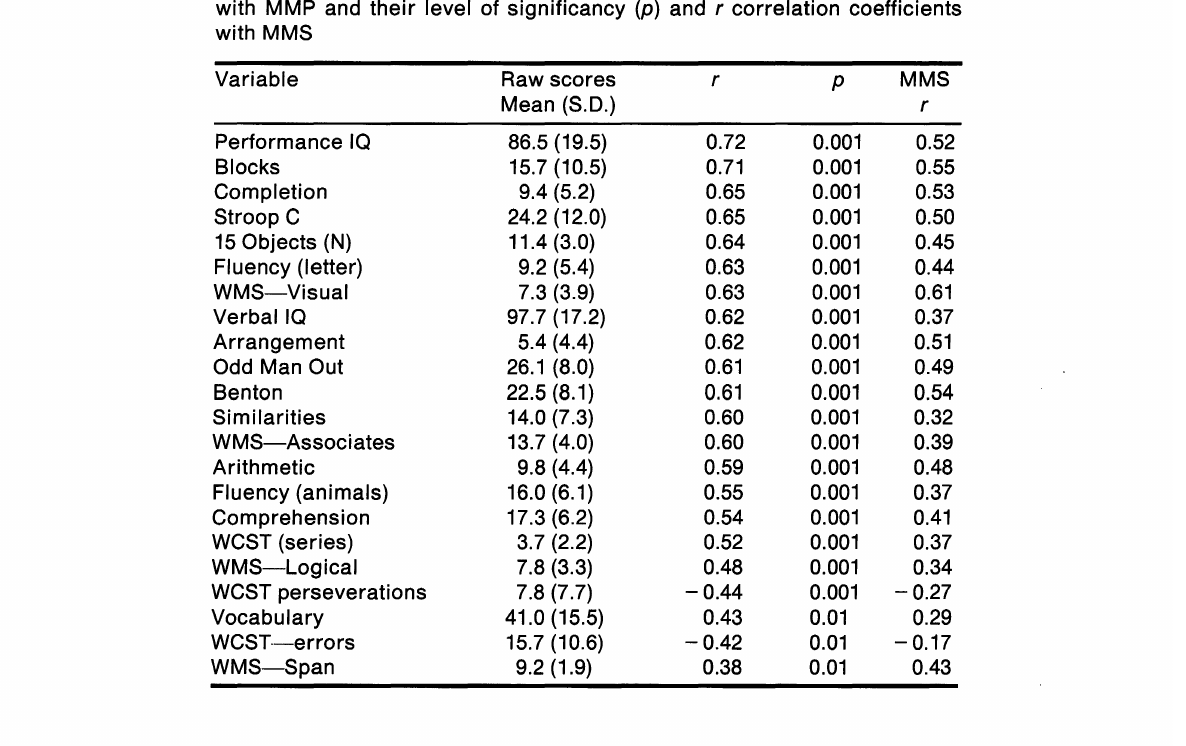
TABLE I II. Construct validity. Mean raw scores of each test of the